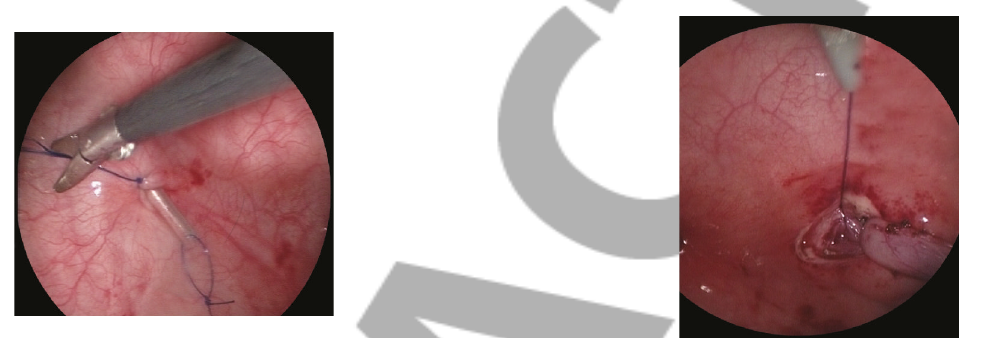
Figure 2: A 3-4cm long segment of an Fr 4 or 5 catheter is inserted into the ureter as a stent to facilitate subsequent ureteral mobilization and dissection, and secured with a 4-zero monofilament suture.